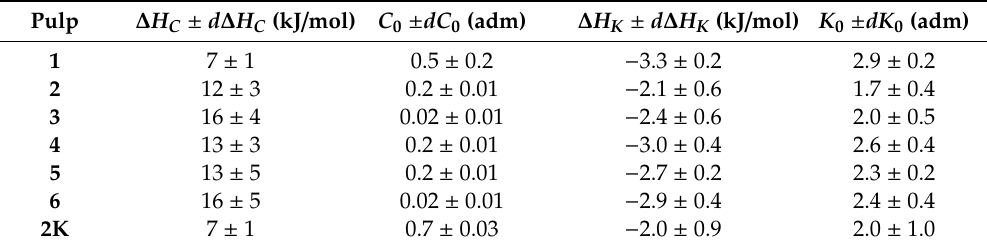
Table 7. Enthalpy di ff erences and entropic accommodation factors between the monolayer